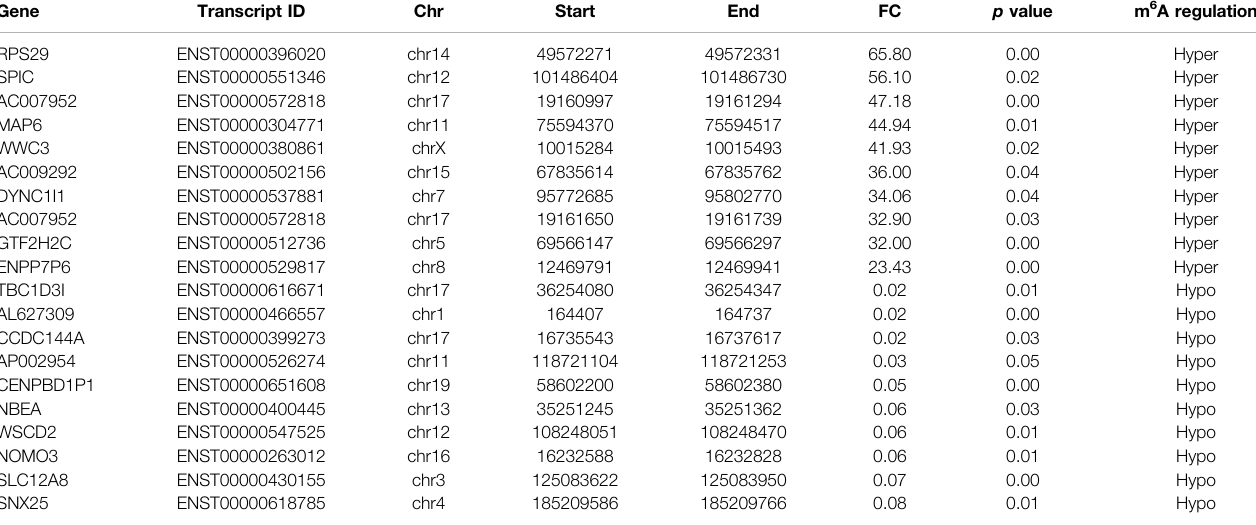
TABLE 1 | Top 20 differentially methylated m 6 A peaks